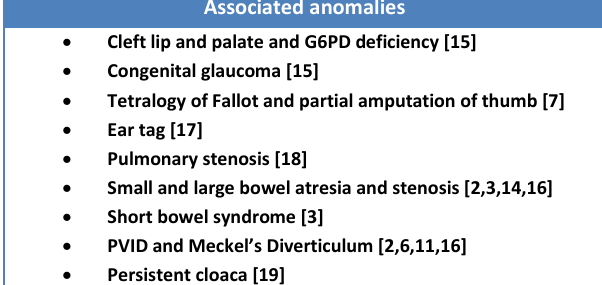
Figure 12: HUC with evisceration of bowel. The bowel is matted to form a discoid mass of gut over the umbilicus. Inset shows application of the ligature by an untrained birth attendant in village setting.